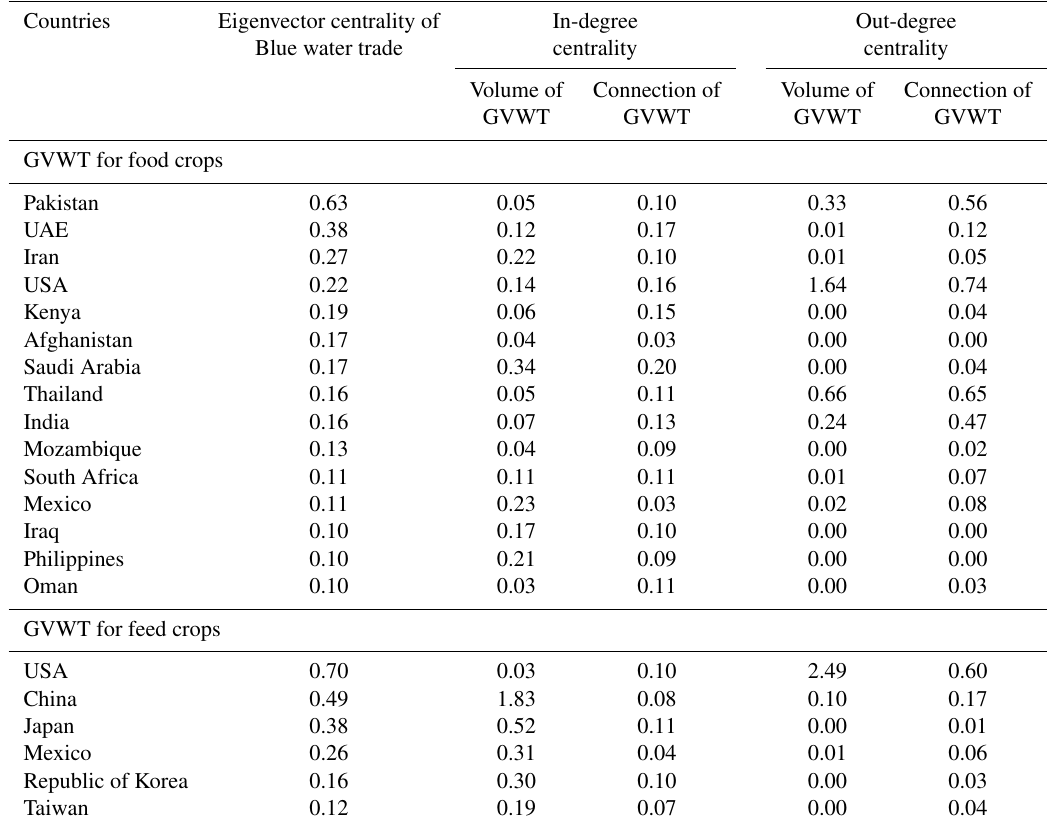
Table 6. Eigenvector and degree centrality of blue water trade and degree centrality of GVWT.